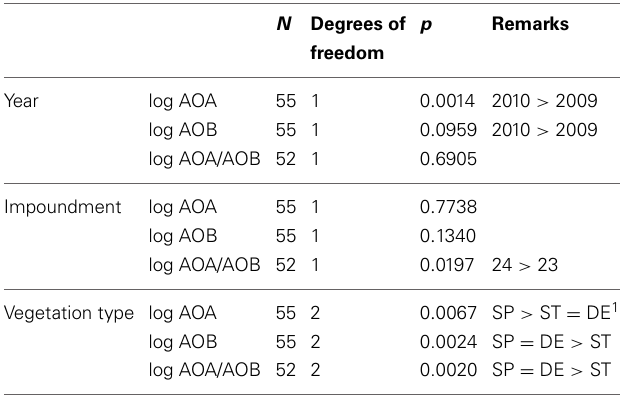
Table 2 | Effect of year of sampling, impoundment and type of Black mangrove vegetation on the archaeal and bacterial amoA gene copy numbers (AOA and AOB, respectively) and their mutual ratio according to a nonparametric Kruskal-Wallis test.